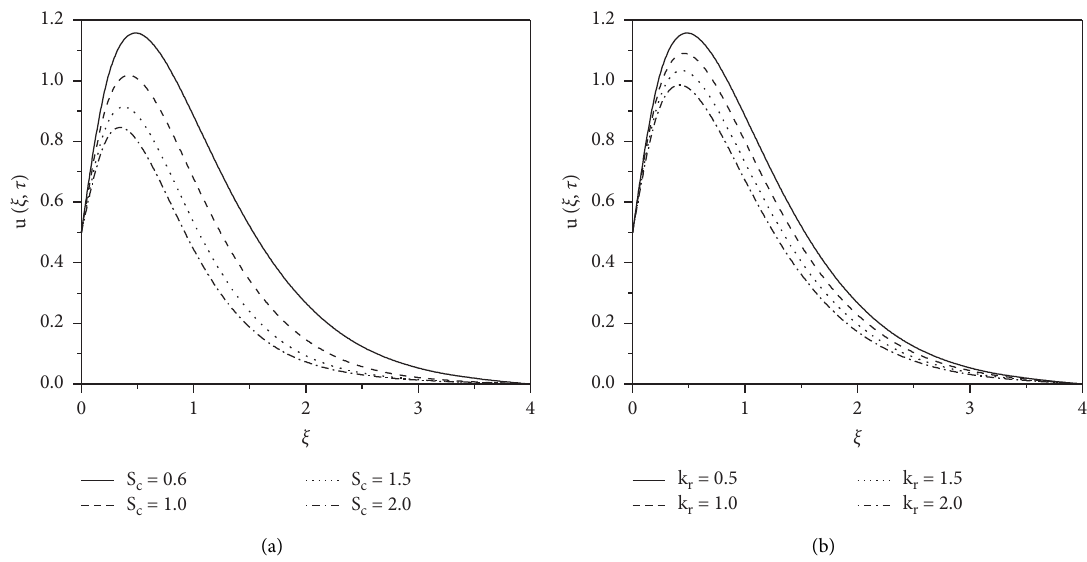
Figure 13: Variation of velocity u ( ξ , τ ) against ξ in the limiting case for various values of (a) S